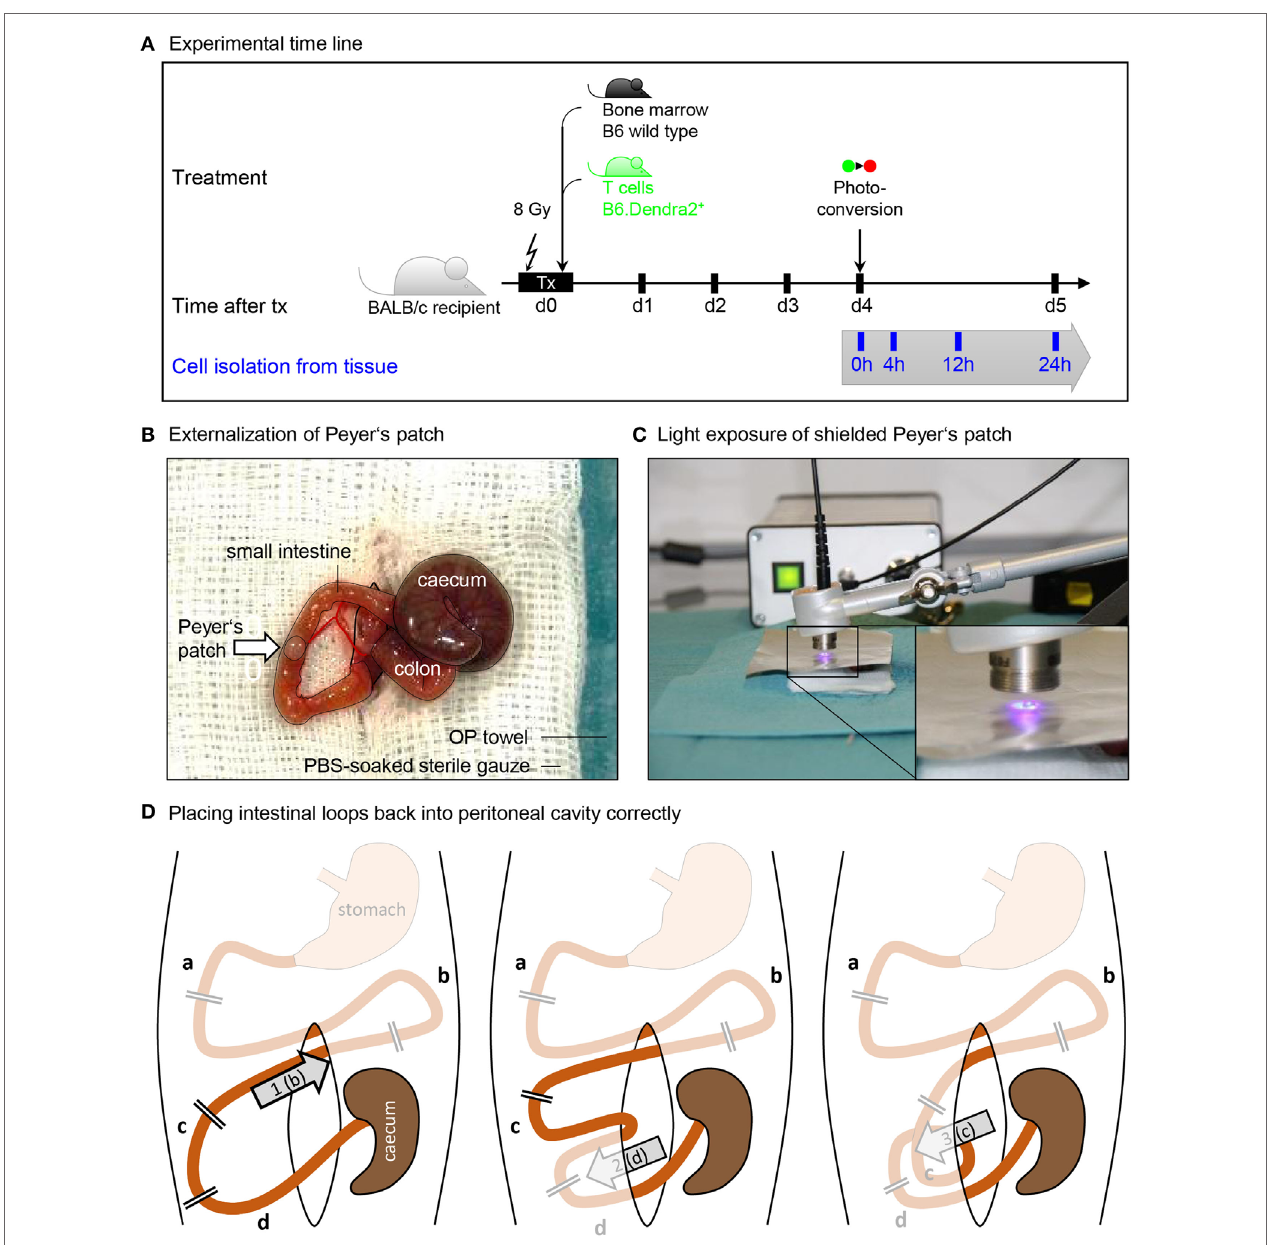
FIGUrE 1 | Procedure of Peyer’s patch photoconversion. (A) Time line of transplantation and photoconversion procedure. BALB/c recipients were maeloablatively irradiated (8 Gy) and transplanted with wild type bone marrow and Dendra2 + T cells. Donor T cells were photoconverted in the Peyer's patches 4 days after transplantation. (b) Photograph of an externalized Peyer’s patch placed on a PBS-soaked sterile gauze. Cecum, colon, peritoneal opening, and small intestine are circled with black lines. (c) Application of a tinfoil stencil to expose a Peyer’s patch to UV light illumination using a high-power LED coupled to a glass fiber. (D) The duodenum (a) and the stomach-proximal part of the jejunum (b) were not externalized when photoconverting the six distal Peyer’s patches closest to the cecum. After photoconversion, (1) the proximal jejunum has to be placed cranial to the cecum. Subsequently, (2) the ileum (d) is placed opposite of the cecum, after which (3) the distal jejunum (c) is placed ventral of the ileum. Finally, the cecum is placed back at the location where it laid on the